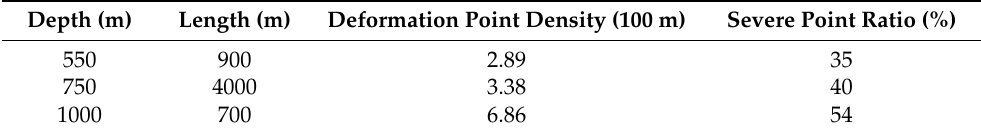
Figure 3. Times and percentage of various failure modes [21,22]. ( a ) Depth of 550 m; ( b ) Depth of 750 m; ( c ); Depth of 1000 m. Table 2. Comparison of roadways with different depths.